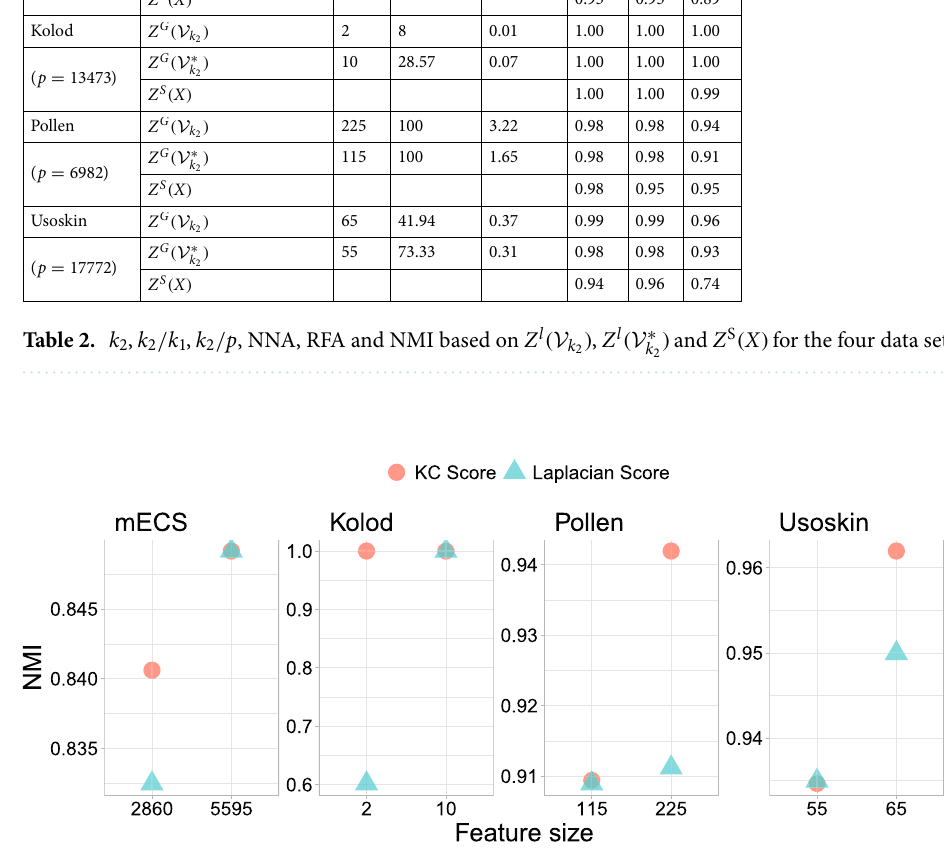
Figure 2. The NMIs based on the two k 2 ’s selected respectively by the KC and Laplacian Scores in Table